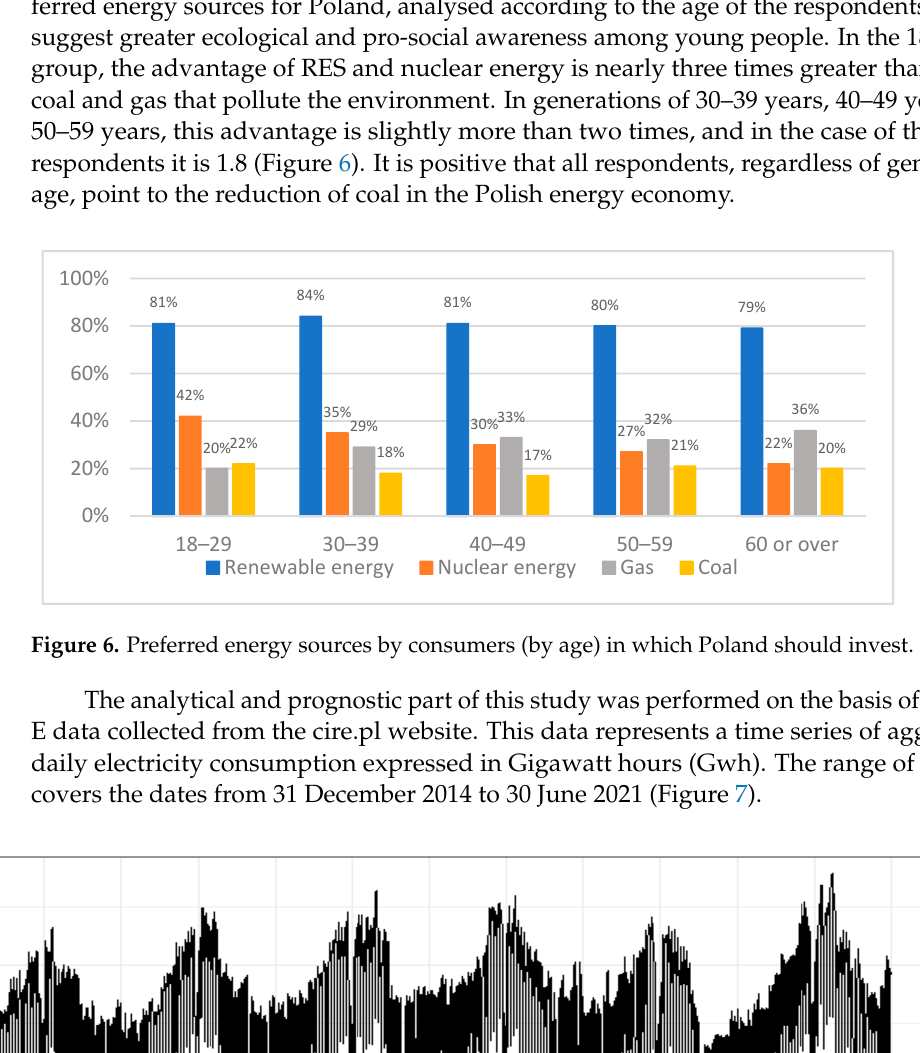
Figure 5. Preferred energy sources by consumers (by gender) in which Poland should invest.